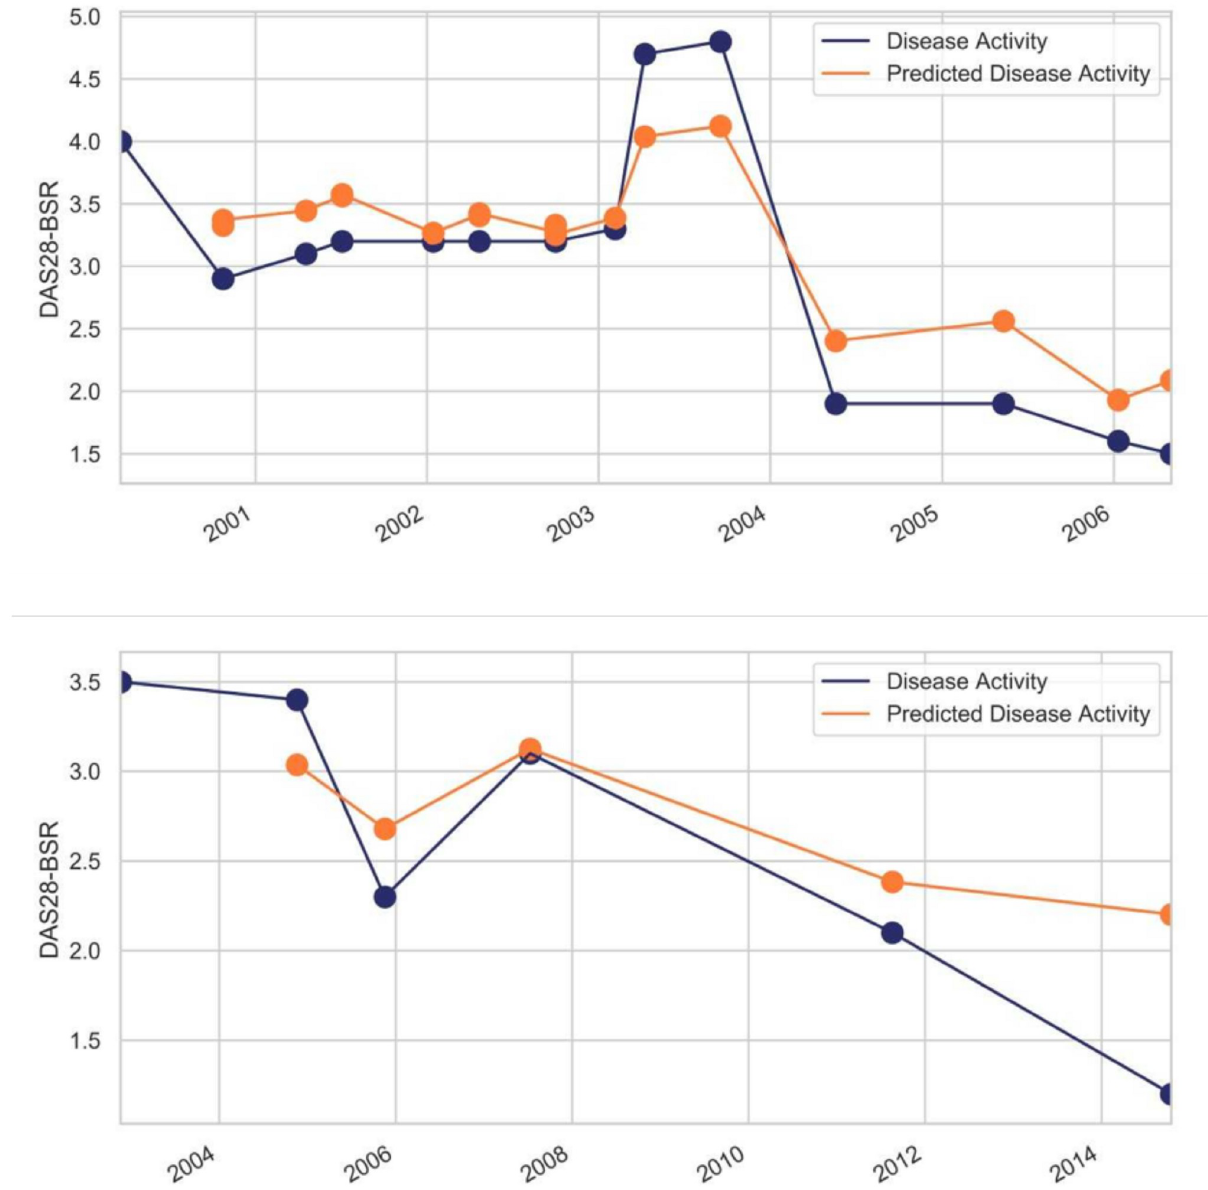
Fig 3. Examples of true disease activity and corresponding predictions of AdaptiveNet by regression analysis. Predictions are made step to step from the current to next visit.